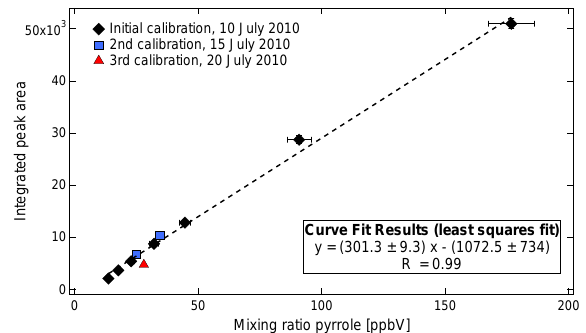
Fig. 4. Three different calibrations for pyrrole within ten days inten- sive measurements at the HUMPPA-COPEC 2010 field campaign: for optimized conditions at the start of the campaign (black), five days later (blue) and after ten days intensive measurement campaign (red). After five days less than 10% deviation of the first calibration curve could be observed. After ten days sensitivity was decreased by